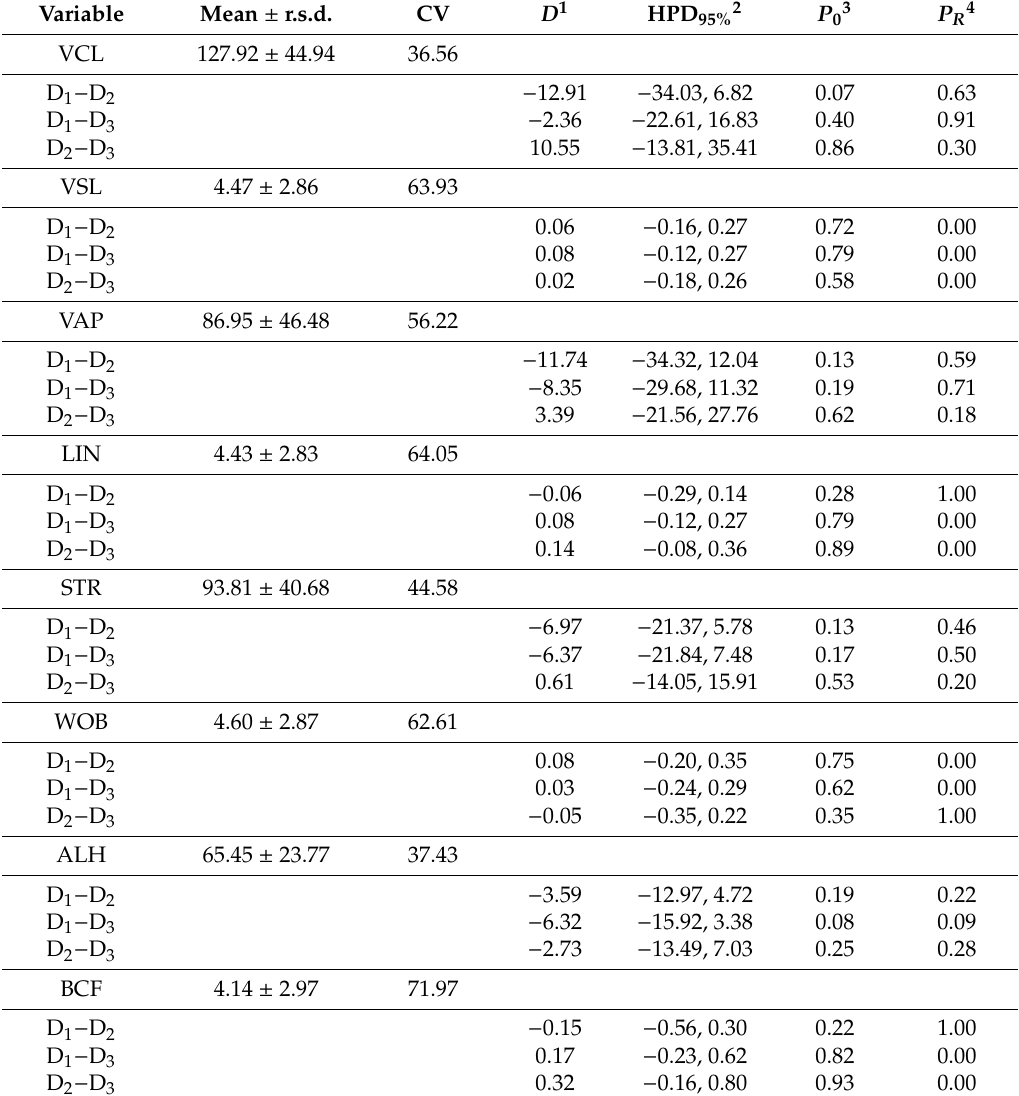
Table 4. Kinematic bull sperm variables and estimated marginal posterior distributions of di ff erences between commercial extenders Tris-EY, Triladyl ® and OptiXcell ® . Variable Mean ±